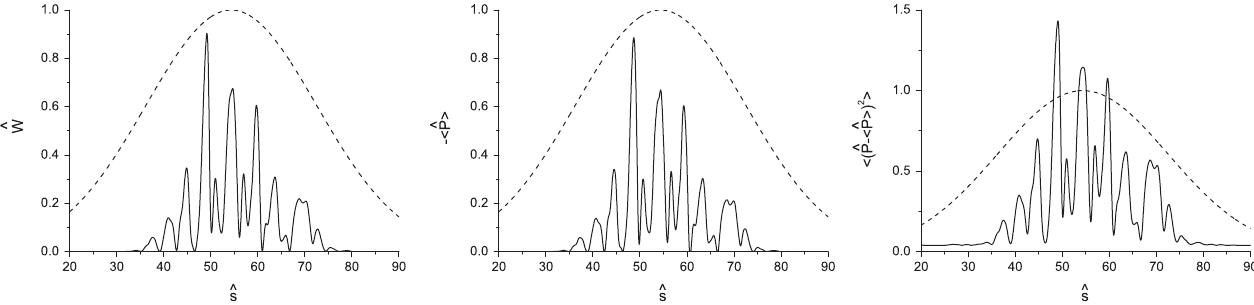
FIG. 2. Scaled radiation power (left), beam energy loss (middle), and the variance of energy distribution (right) versus scaled position along the bunch for a SASE FEL operating close to saturation (two field gain lengths before saturation). Undisturbed energy ^(cid:1) ¼ 0 : 2 . Simulations were performed with the 1D version of the code FAST [20]. The electron bunch profile is shown in spread is T dashed